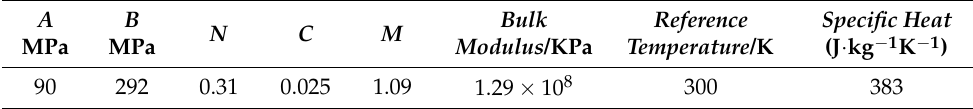
Table 1. Parameters of the constitutive model of the liner [38].